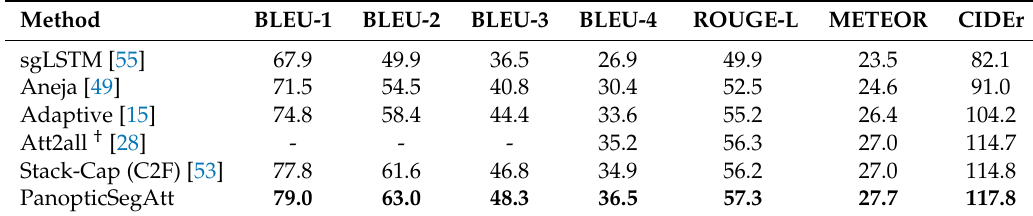
Table 2. The results obtained on the online MSCOCO test server. † indicates ensemble models. Higher is better in all columns. Scores are multiplied by a factor of